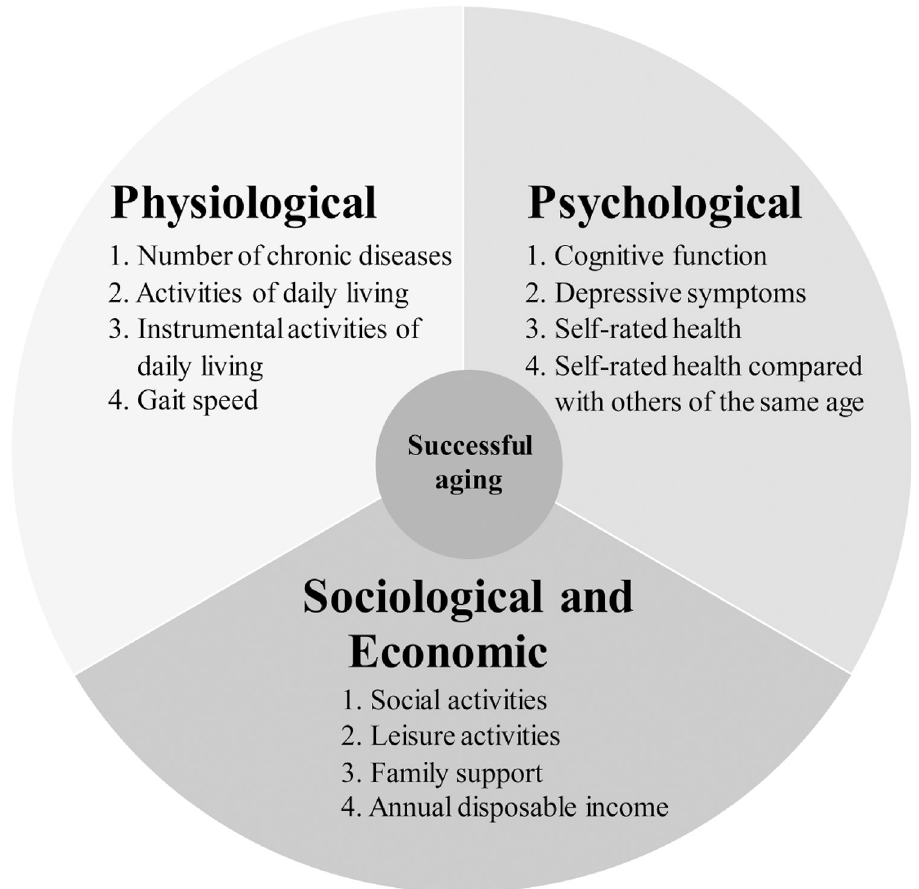
Fig 1. The definitions of successful